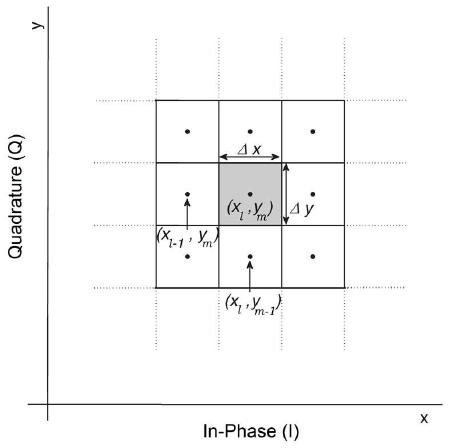
Figure 10. Discretization of received symbols.